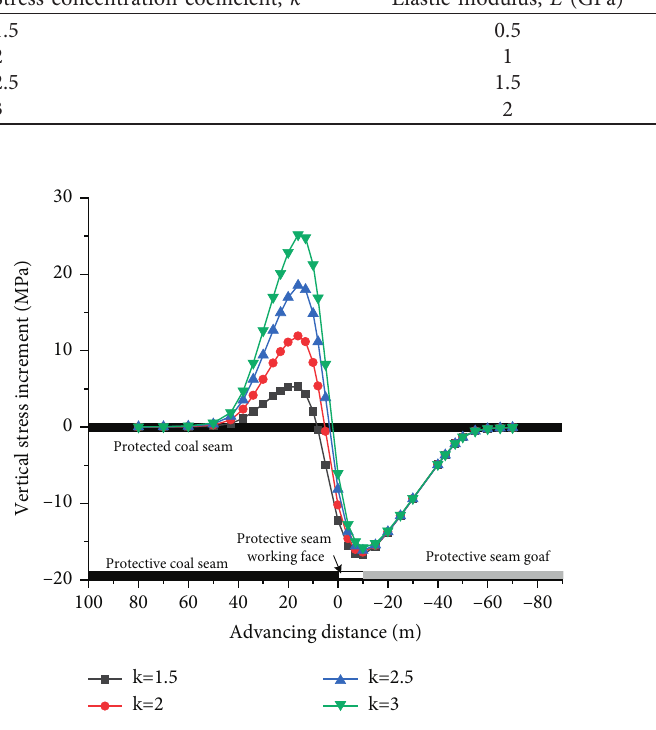
Figure 4: Different stress concentration coefficient stress variation curves.